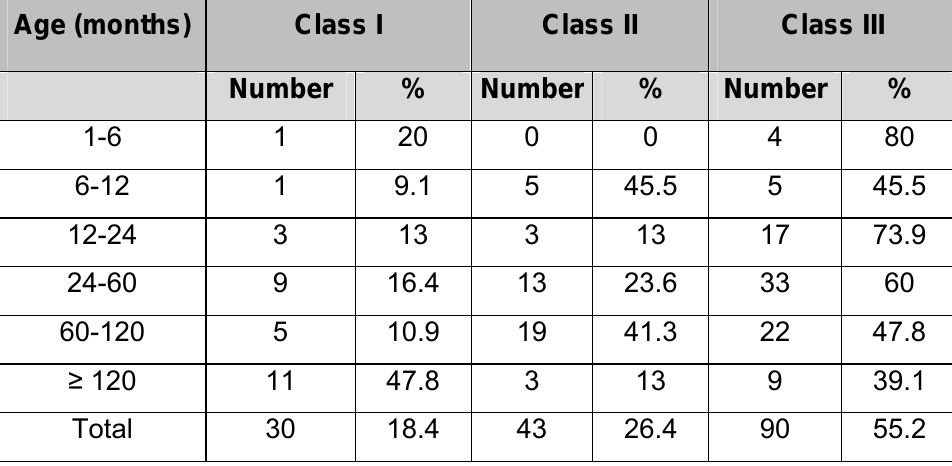
Table 4. Age distribution of stung children according to severity class Age